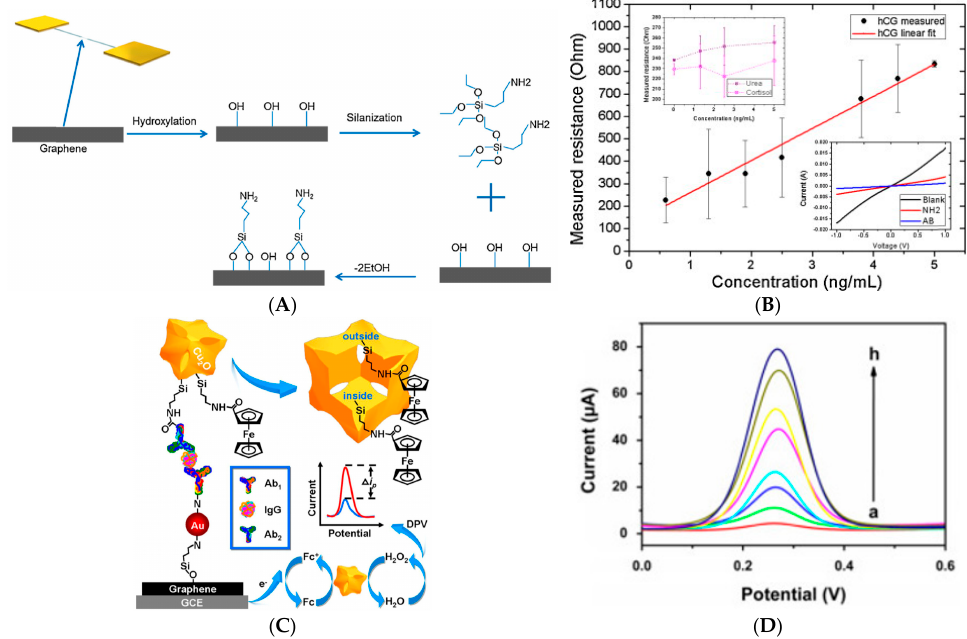
Figure 10. ( A ) Covalent attachment of 3-aminopropyltriethoxysilane (APTES) to a hydroxyl-terminated graphene surface; ( B ) Resistance across a 100 μ m × 4 mm graphene channel as a function of the hCG concentration. Resistance across the channel as a function of the urea and cortisol concentration (inset, top left). I–V curves are plotted (inset, bottom right) for the unmodified device (black curve), amine-terminated (red curve), and Ab-modified (blue curve) graphene surface. Reprinted from [59], Copyright 2014, with permission from Elsevier. ( C ) Sandwich-type electrochemical immunosensor based of Fc-modified Cu 2 ONPs, for PSA detection. ( D ) SWVs for detection of 0.05 pg mL − 1 (a), 0.1 pg mL − 1 (b), 0.5 pg mL − 1 (c), 1 pg mL − 1 (d), 5 pg mL − 1 (e), 10 pg mL − 1 (f), 50 pg mL − 1 (g) and 100 pg mL − 1 (h) PSA. Reprinted from [62], Copyright 2016, with permission from Elsevier.